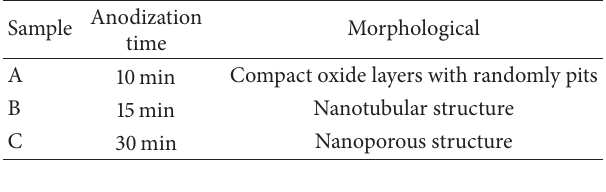
samples via electrochemical 3